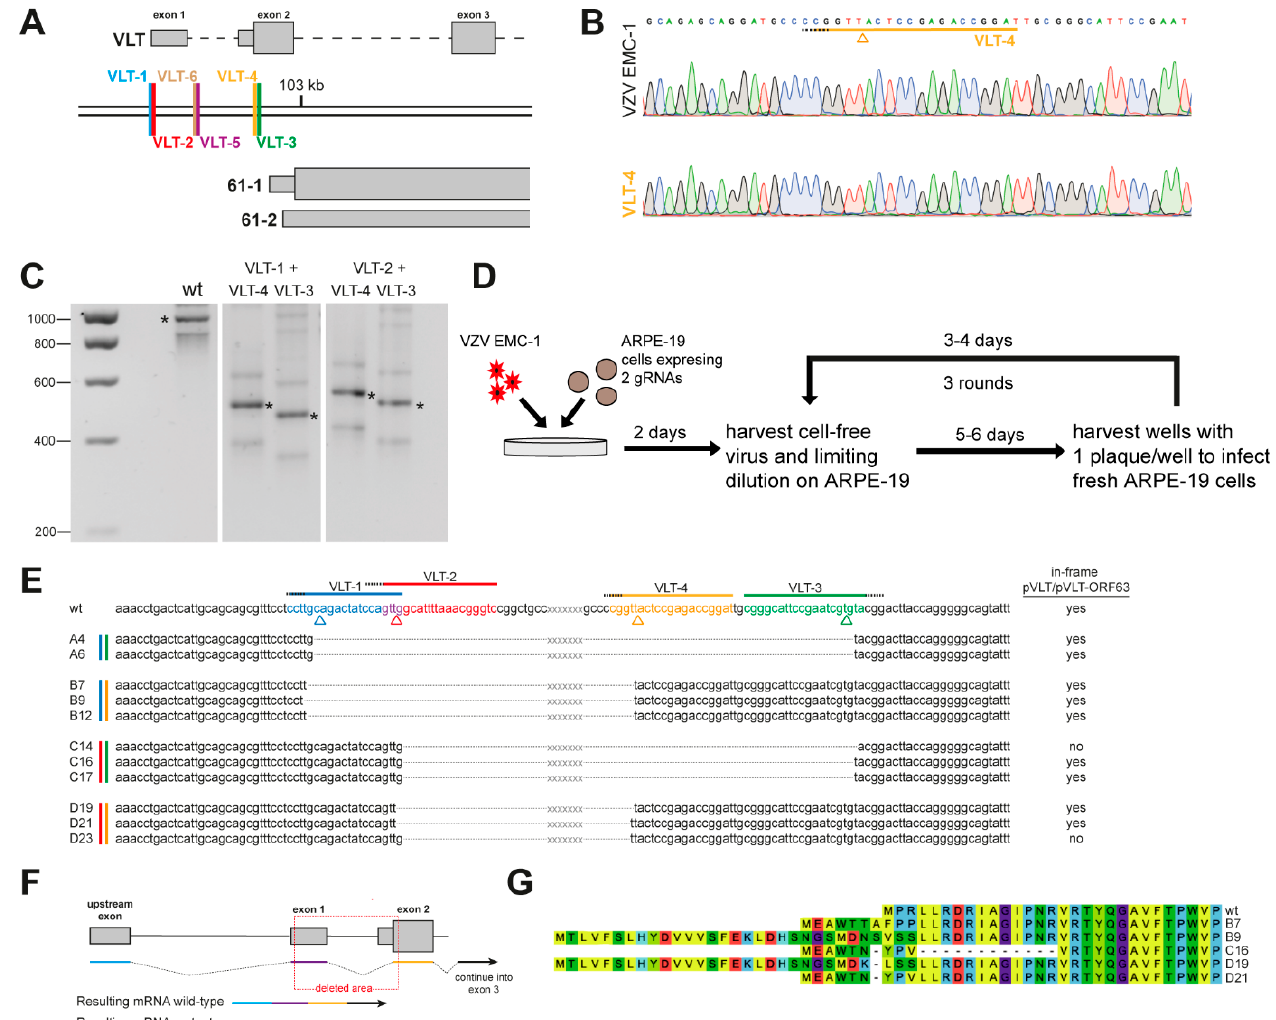
Figure 3. Generation of VZV latency-associated transcript (VLT) mutant viruses using combinations of two different sgRNAs. ( A ) Schematic illustration of the VLT target region: thick double black lines represent the VZV genome, annotated RNAs are depicted in grey—wide boxes are coding sequences (CDS), thin boxes are untranslated regions (UTRs) and dashed lines are intronic sequences—and the DNA target sites of sgRNAs VLT-1 to VLT-6 are depicted in differentially colored lines. ( B ) Sanger sequencing traces showing the sgRNA target region (yellow), PAM sequence (dashed black) and cleavage site (colored triangle) for wild-type VZV EMC-1 DNA (top) and DNA extracted from VZV EMC-1 infected stably transduced VLT-4 cells (bottom). ( C ) PCR products from VLT upstream exon C to VLT exon 2 on DNA isolated from parental ARPE-19 cells or from cells stably transduced with a combination of sgRNAs as indicated 2 days post-infection with VZV EMC-1. Correct band is indicated by an asterisk, additional bands result from duplication of primer binding site in R5. ( D ) Experimental design: Stably transduced ARPE-19 cells expressing two sgRNAs targeting the VLT region were infected with VZV EMC-1. Two days post-infection, cell-free virus was harvested, and subjected to three subsequent rounds of plaque purification. ( E ) VZV DNA sequence around sgRNA target sites of isolated plaque purified viruses divided into 4 groups: A—combination of sgRNA VLT-1 and sgRNA VLT-3, B—combination of sgRNA VLT-1 and sgRNA VLT-4, C—combination of sgRNA VLT-2 and VLT-3, D—combination of sgRNA VLT-2 and VLT-4. Dashed lines represent deleted nucleotides, whereas ‘xxx’ signifies the region in between the sgRNAs target sequences deleted in all mutants. PAM sequences (dashed black) and expected cleavage sites (colored triangles) are indicated. ( F ) Schematic illustration of VLT transcript generation from wild-type or mutant viruses from any upstream VLT exon (blue line), into exon 1 (purple line), exon 2 (orange line) and the remainder of VLT (black arrow). ( G ) Alignment of proteins generated in mutant viruses by in-frame splicing of an upstream ATG with the remainder of pVLT/pVLT-ORF63. Amino acids are colored to aid visual